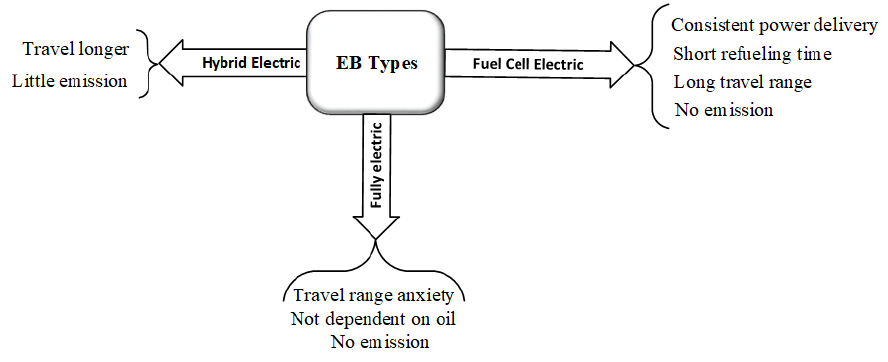
Figure 4. Different types of EBs. Table 3. Comparison of functional and operational differences between conventional buses and electric